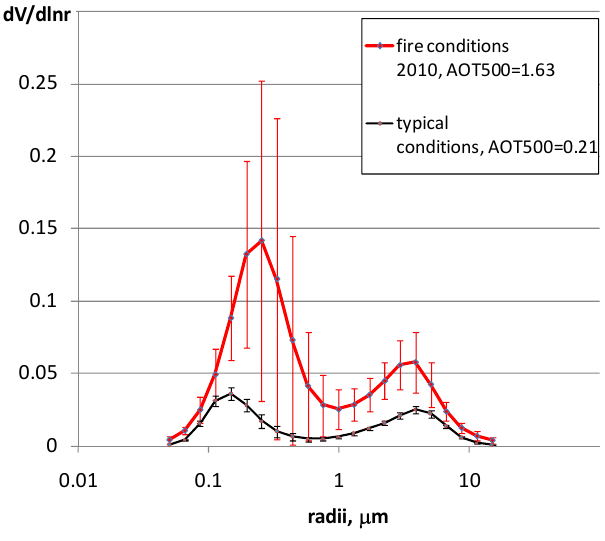
Fig. 6. Mean aerosol volume size distribution dV (r)/d ln r Fig.6. Mean aerosol volume size distribution in fire conditions (red), August 2010, and (µm 3 /µm 2 ) in fire conditions (red), August 2010, and typical August typical August conditions (black) with the confidence intervals at 95%. AOT500 values in conditions (black) with the confidence intervals at 95%. AOT500 the legend are the averages corresponding to the samples. Moscow. values in the legend are the averages corresponding to the samples. Moscow.